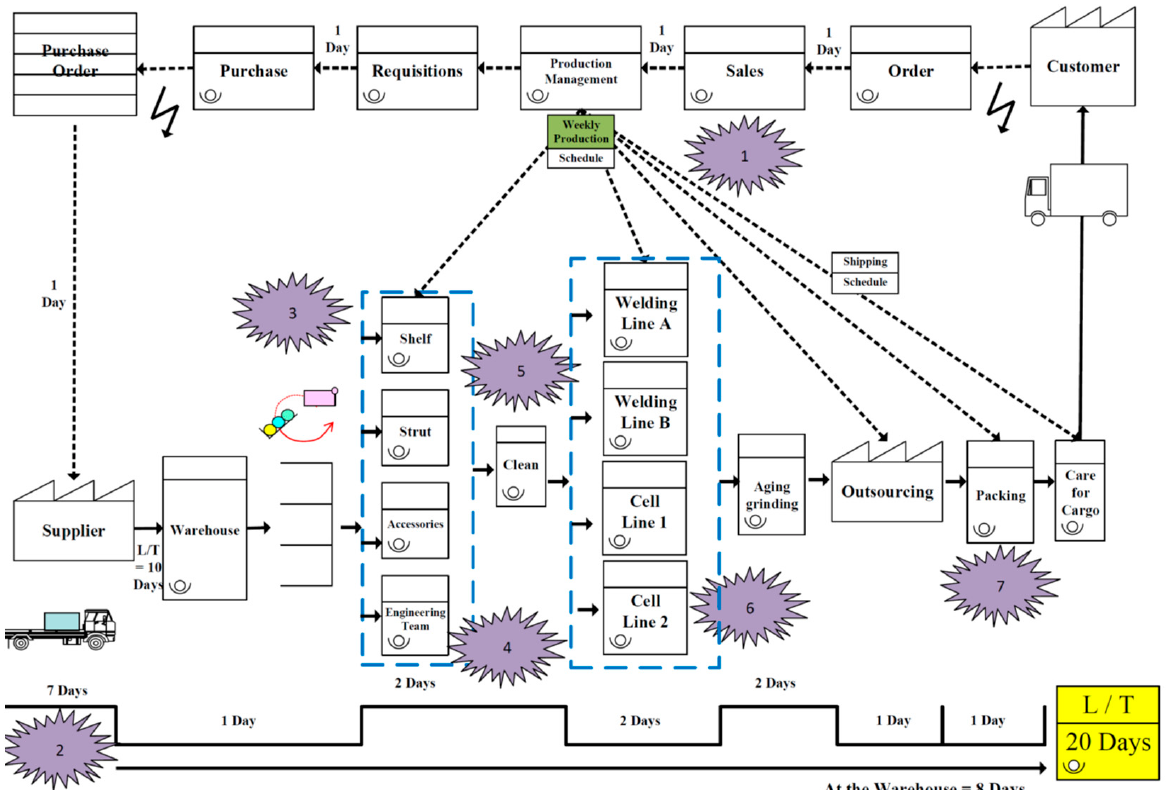
Figure 4. Future VSM.